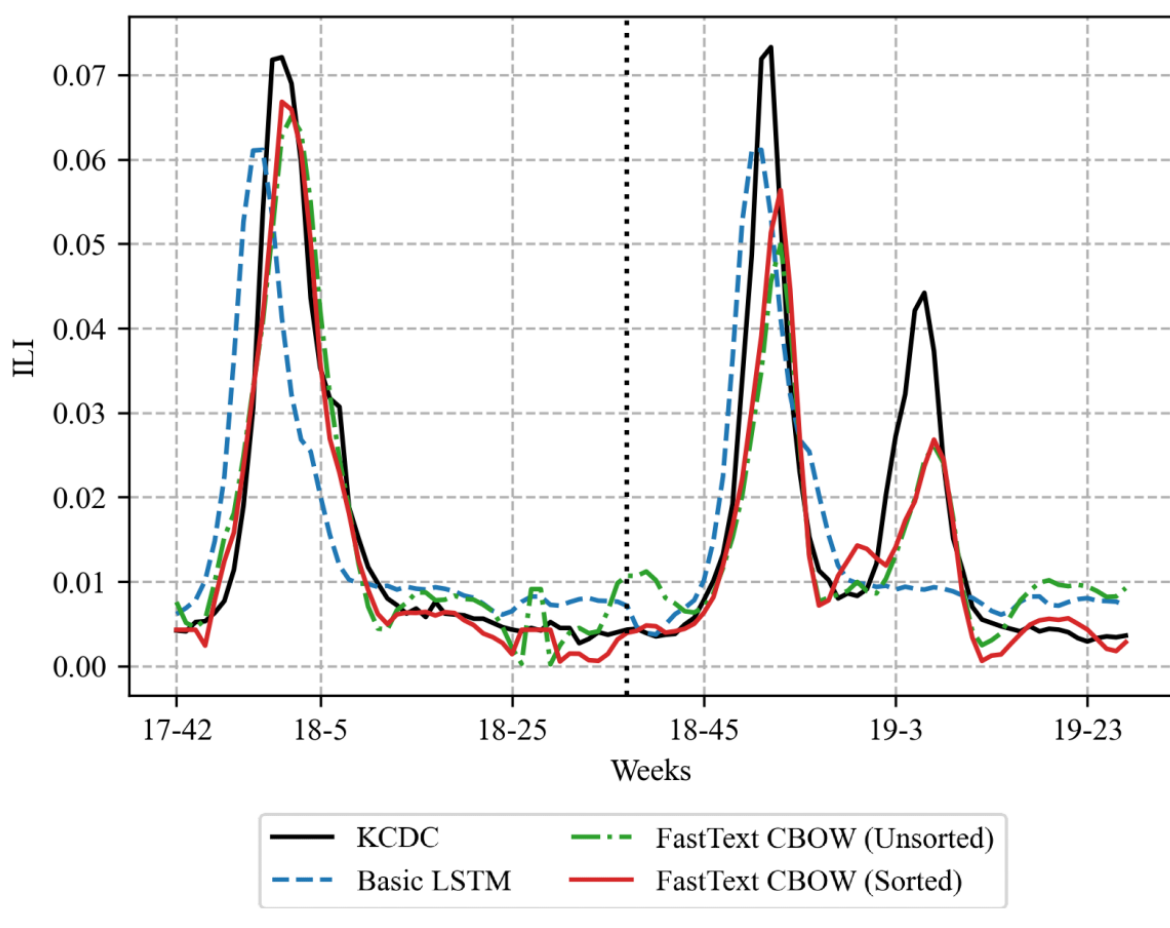
Figure 7. Comparison of actual influenza outbreaks and influenza prediction results from prediction models. CBOW: continuous bag-of-words; ILI: influenza-like illness; KCDC: Korea Centers for Disease Control and Prevention; LSTM: long short-term